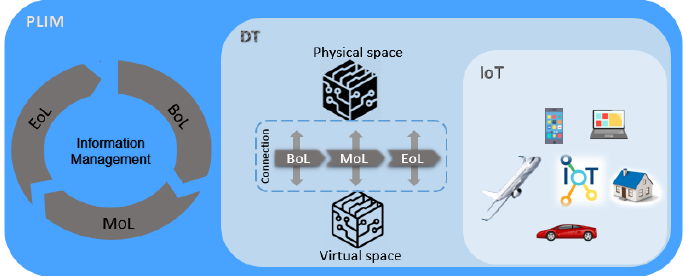
Figure 2. Intersection among PLIM, IoT, and